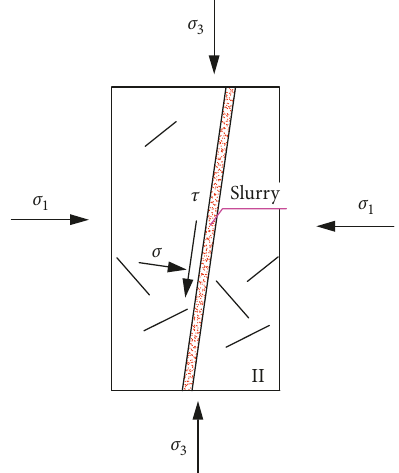
Figure 1: Model of fracture filled with cement slurry through the rock sample